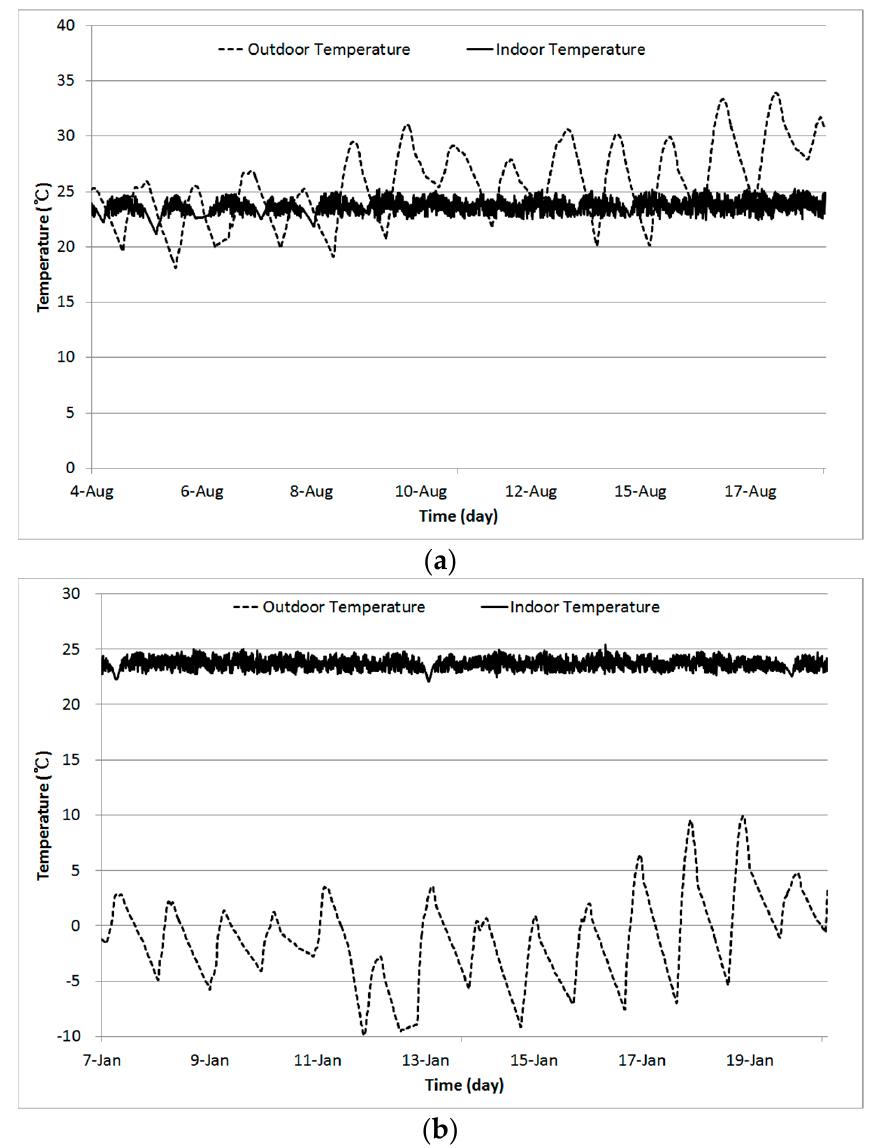
Figure 11. Indoor temperature in the existing CASE: ( a ) Summer; ( b ) Winter.